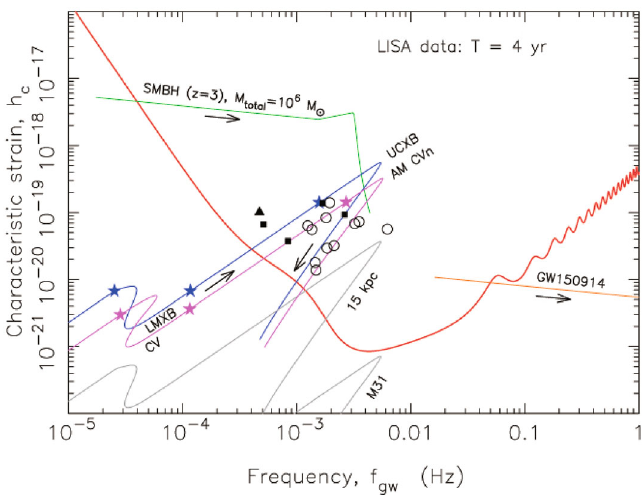
Fig. 4 Characteristic strain amplitude vs GW frequency for LISA. Evolutionary tracks are for an UCXB (blue) and an AM CVn system (magenta) at a distance of d L ¼ 1 kpc. Their slope on the inspiral leg is / f 7 = 6 gw . The stars along the tracks represent (with increasing GW frequency) onset LMXB/CV stage, termination LMXB/CV stage, and onset UCXB/AM CVn stage. The evolutionary timescales along these tracks are shown in Fig. 5. The LISA sensitivity curve (red line, SNR ¼ 1) is based on 4 years of observations. The grey curves are for the UCXB at d L ¼ 15 kpc and 780 kpc (M31), respectively. Comparison tracks are shown for an MBH merger (green) and GW150914 (orange). Their inspiral slopes are / f (cid:4) 1 = 6 gw . Data from LISA veri fi cation sources (Kupfer et al. 2018) include detached double WD binaries (solid squares), AM CVn systems (open circles), and a hot subdwarf binary (solid triangle). Image reproduced with permission from Tauris (2018), copyright by